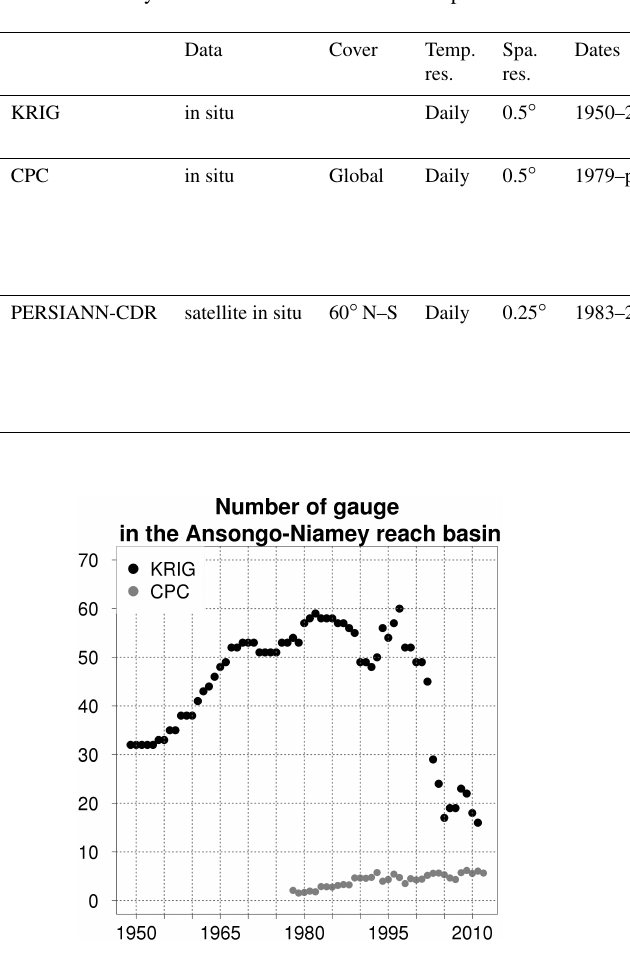
Figure 3. Number of rain gauges for the two in situ rainfall es- timates products KRIG (black dots) and CPC (grey dots) on the Ansongo–Niamey reach basin.